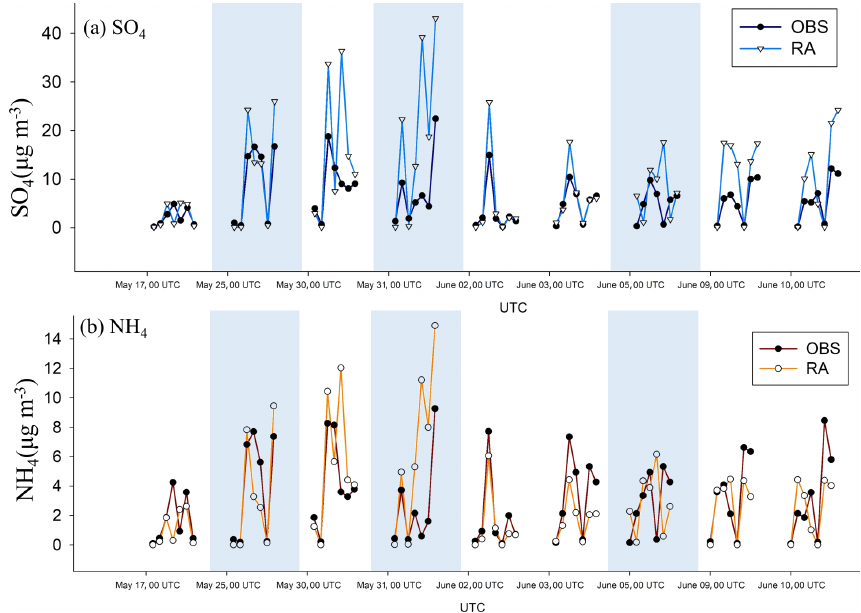
Figure 1. Time variation of the mass concentrations of (a) sulfate and (b) ammonium measured by the NASA DC-8 aircraft (OBS, black line) and simulated by RA (colored line). The blue shaded regions denote the time over the sea.